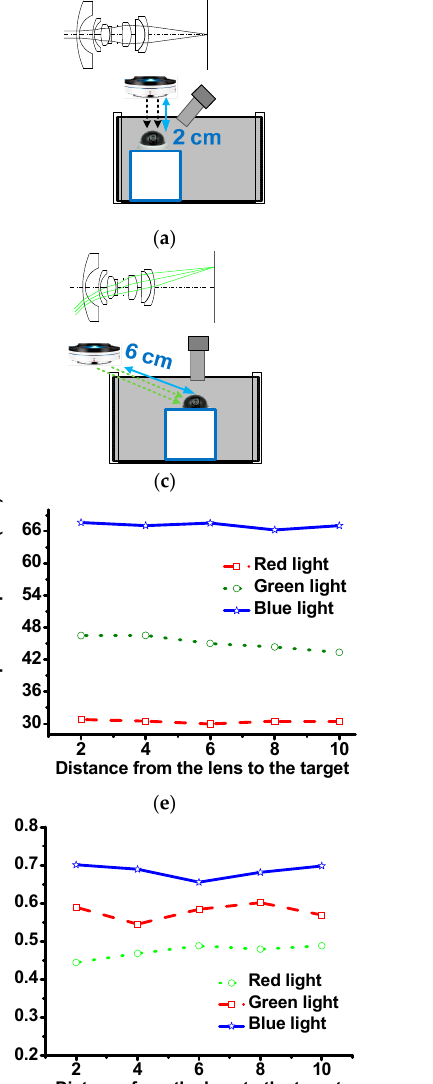
fields of view can be achieved using the fisheye lens system. The − 6 dB bandwidths and pulse widths measurements confirm that similar echo signal amplitudes and center frequencies could be results shown in Figure 10f,h demonstrates that the variances of the bandwidths and pulse widths are obtained. In Figure 10g, the pulse widths measured using red, green, and blue LED lights are 0.444, less than 10% and 3%, respectively. These results indicate that the fisheye lens system presented in this 0.468, 0.488, 0.479 and 0.489 μ s; 0.589, 0.545, 0.584, 0.601, and 0.569 μ s; and 0.701, 0.678, 0.655, 0.681 report can support a wide field of view. and 0.698 μ s, respectively.